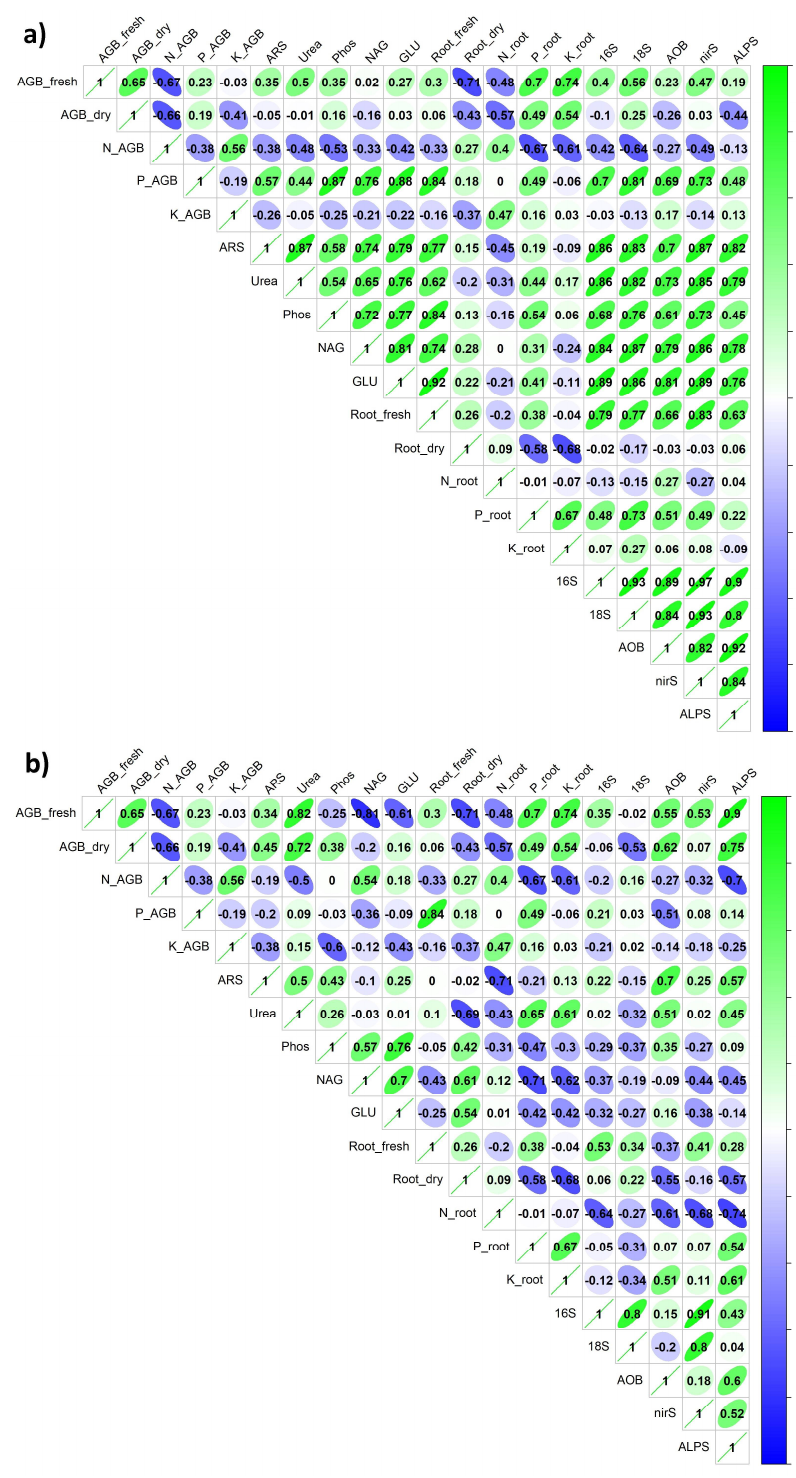
Figure A2. Pearson’s correlation analyses of the properties of rhizosoil ( a ) and bulk soil ( b ) and plant biomass. Abbreviations are: (AGB-fresh, dry); fresh and dry aboveground biomass, (root-fresh, dry); fresh and dry root biomass, (N-, P-, K- AGB or root); biomass nutrient (N,P,K) in AGB or roots, (16S, 18S, AOB, NirS , ALPS); bacterial, fungal, ammonium oxidizing bacteria, denitrifying bacteria and phosphorus solubilizing bacteria and (Glu, ARS, Phos, NAG, Ure); β -glucosidase, arylsulfatase, phosphatase, N-acetyl- β -D-glucosaminidase, and urease enzymes,